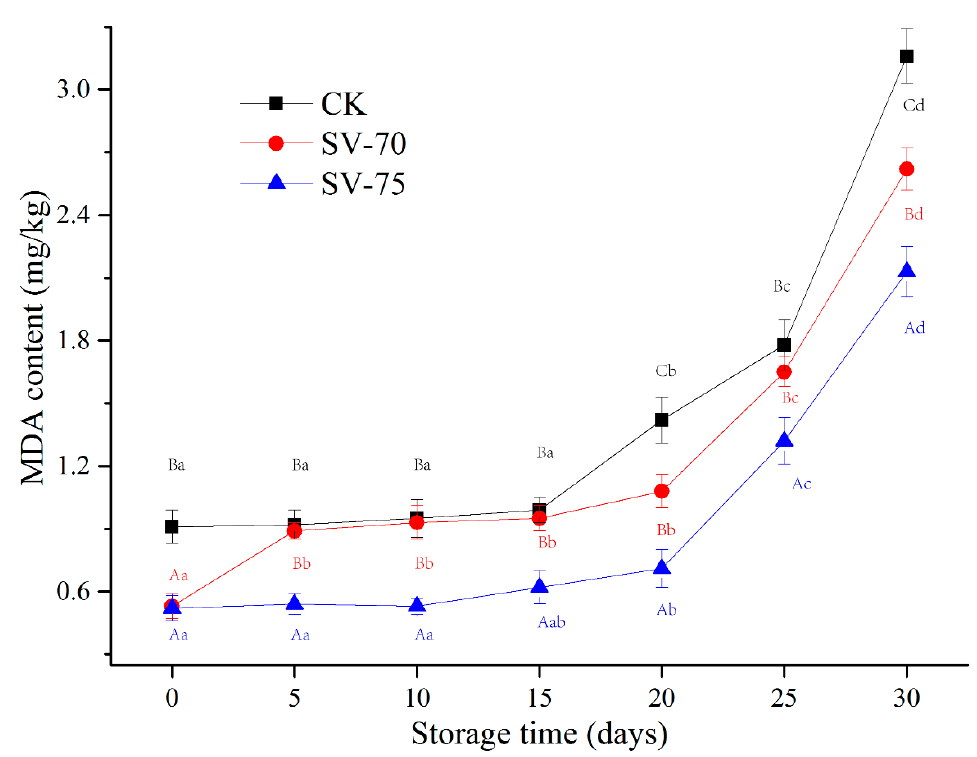
Figure 4. Changes in MDA content of scallop muscle with different treatments during 30 d of chilled storage. Different lowercase letters in the same color for the same point plot indicate significant difference ( p < 0.05), and different uppercase letters in the same storage time indicate significant difference ( p < 0.05).